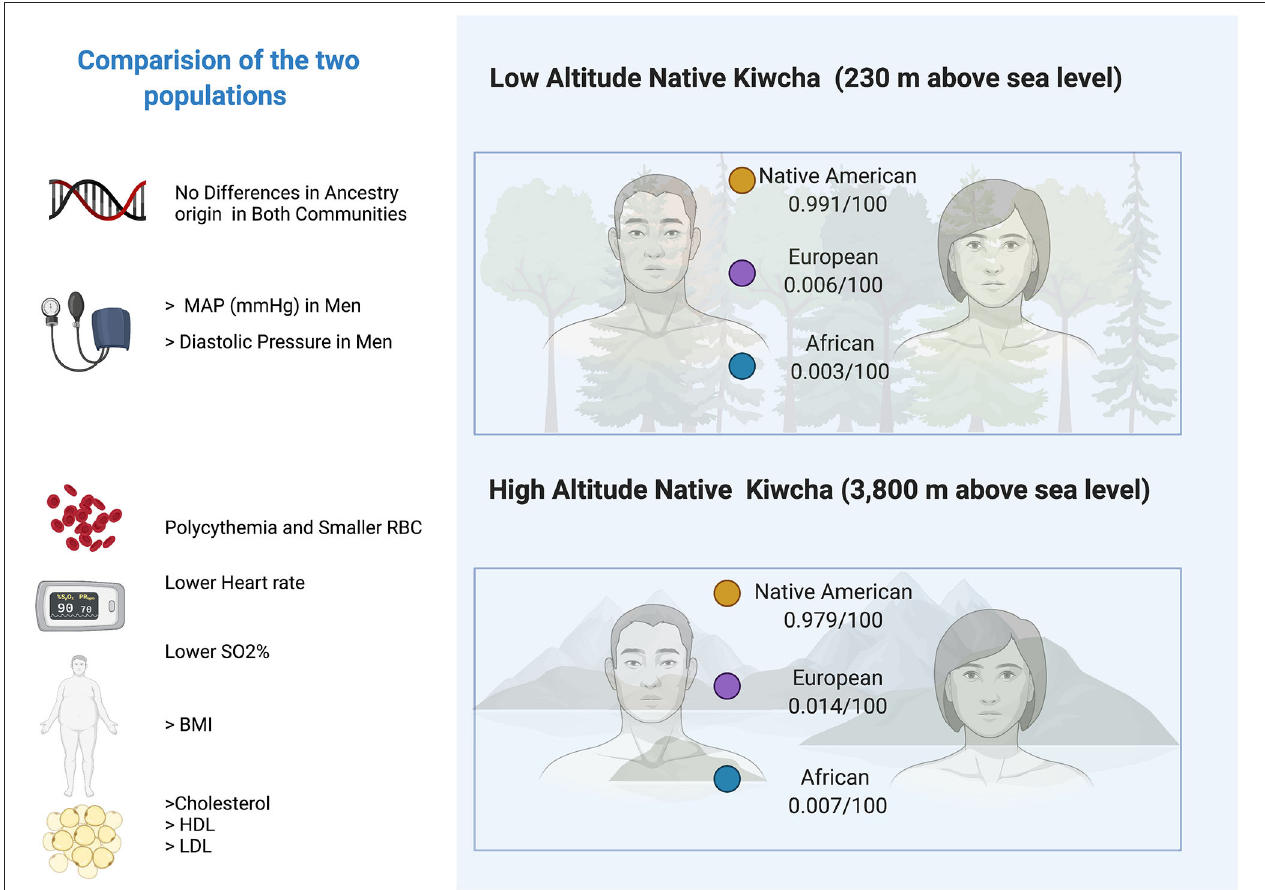
FIGURE 5 | Digital infographic showing the main clinical differences between the inhabitants of Limoncocha (low altitude) and Oyacachi (high